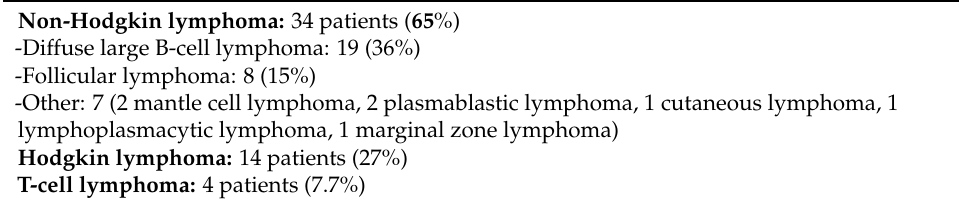
Table 2. Specific types of